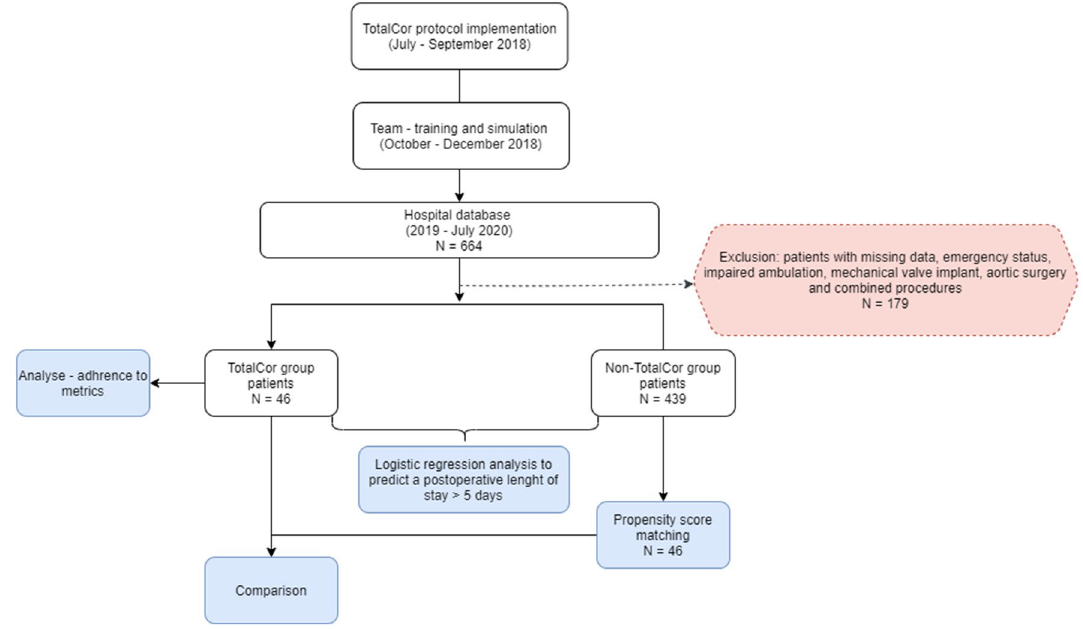
Figure 1. Flowchart of patient selection in the present